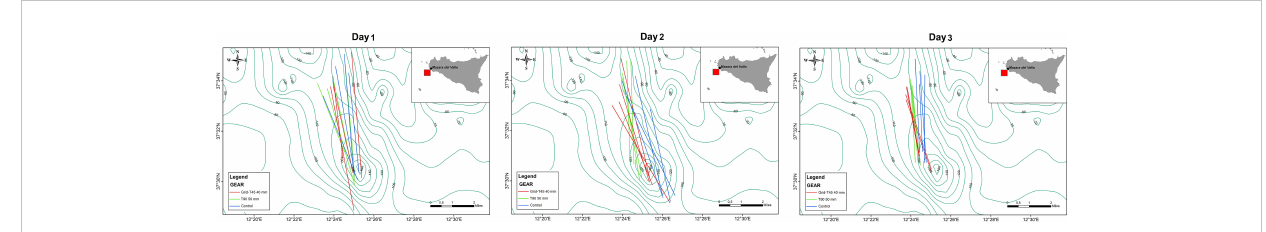
FIGURE 1 Maps of the hauls carried out with the control (blue line), T90 50 mm codend (green line), and Grid-T45 40 mm (red line) nets over 3 days of the survey. The study area is highlighted with a red square